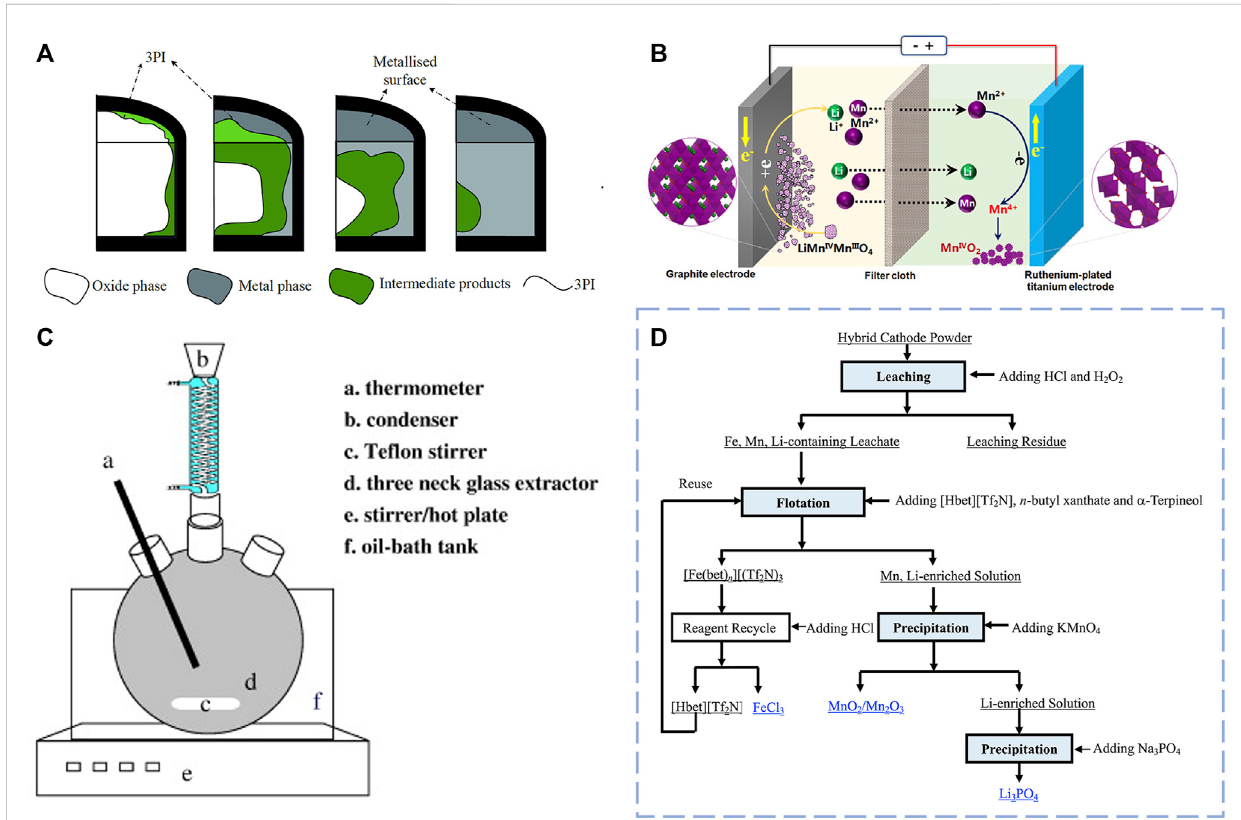
FIGURE 4 (A) Schematic diagram of LMO molten salt recovery process by high-pressure electrolysis; (B) Transformation mechanism diagram of Li and Mn during electrolytic recovery; (C) Experimental setup for leaching and recovery material processes; (D) Flowchart of hybrid material treatment and